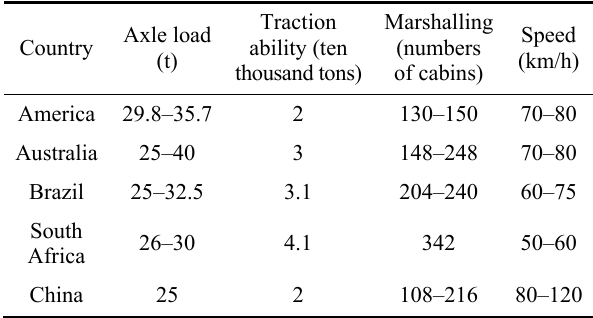
Table 3 Different heavy-duty trains in the